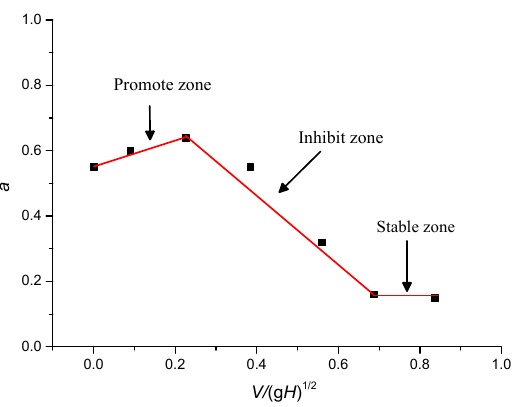
(cid:112) g H with dam-board at the corridor